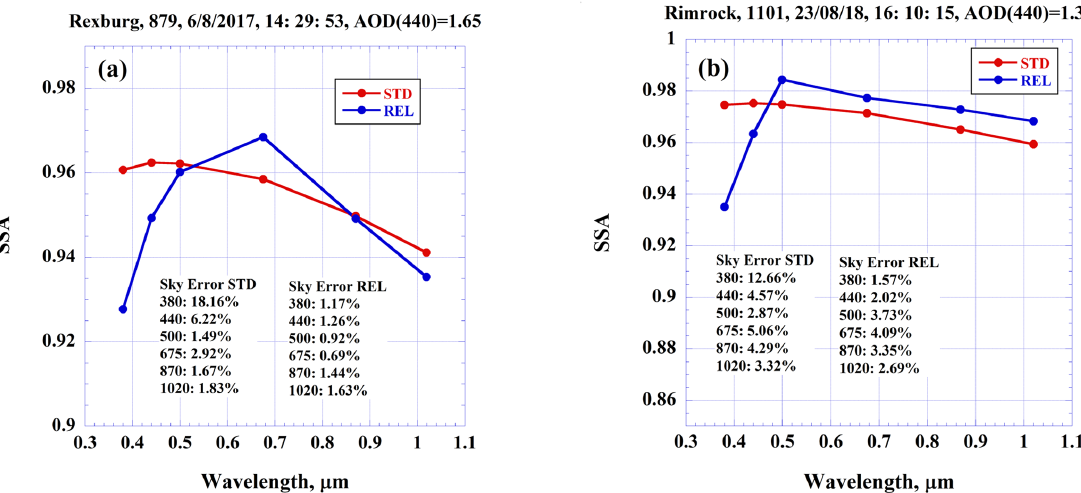
Figure 1. SSA retrieved using V3 assumptions on the IPRI smoothness constants (STD) and that of relaxed constraints (REL): (a) Rexburg (AOD(440) = 1.65, AE = 1.74) and (a) Rimrock (AOD(440) = 1.33, AE = 1.79) AERONET sites.